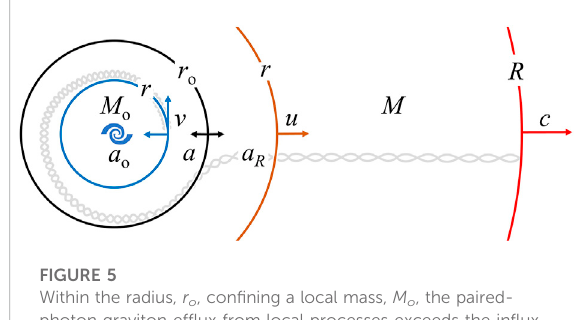
FIGURE 5 Within the radius, r o , con fi ning a local mass, M o , the paired- photon graviton ef fl ux from local processes exceeds the in fl ux fromdistantsources.Thus,abodyspiralsinwarduntil v 2 / r balances the sum of the universal, a , and local, a o , acceleration. Since the circumference, 2 π r , shortens, graviton by graviton, as much as the distant space lengthens along with radius, r , the inward and outward acceleration relate as a = a R /2 π . Beyond r o , the graviton in fl ux from numerous processes transforming matter into space exceeds the ef fl ux. Thus, the body recedes at speed, u < c . At R , enclosing all mass, M , the total graviton fl ux from all processes generates the expansion at the speed of light, c